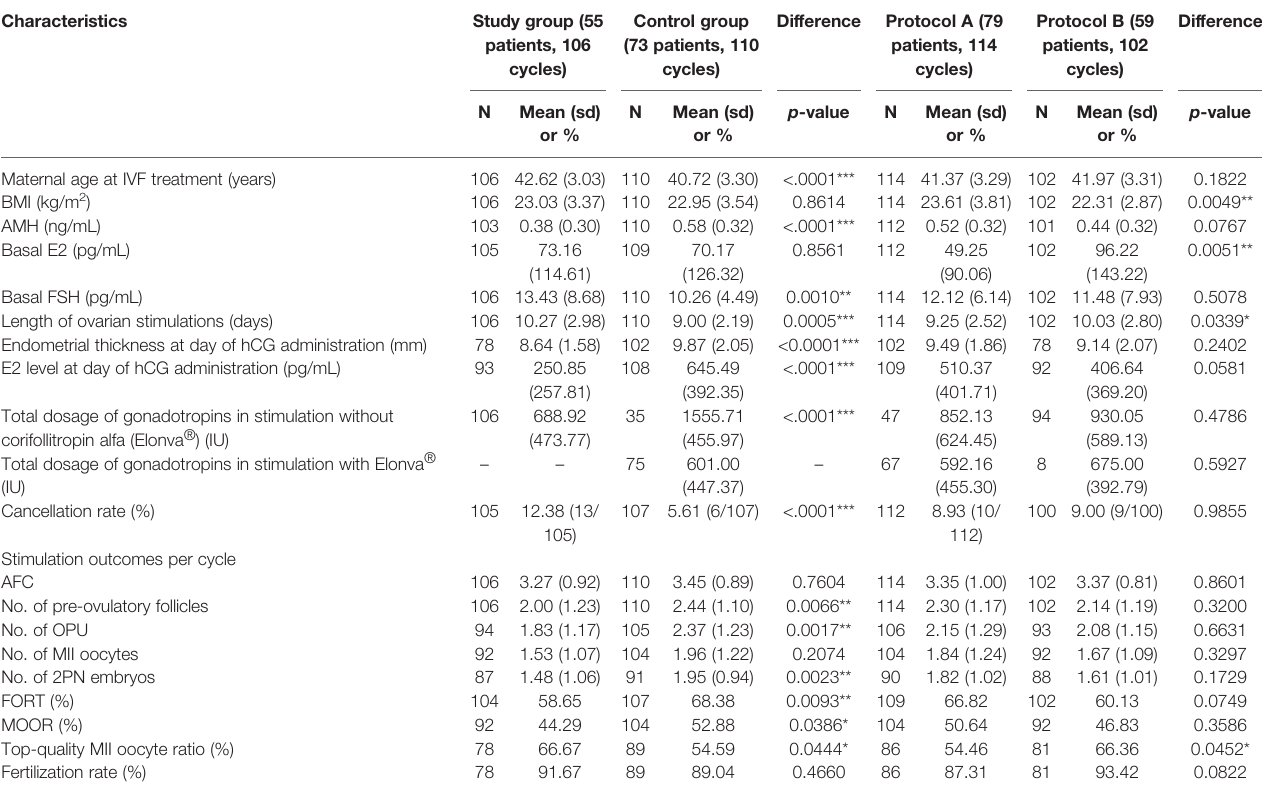
TABLE 1 | Patient characteristics strati fi ed by treatment protocol among patients receiving stimulation protocols.